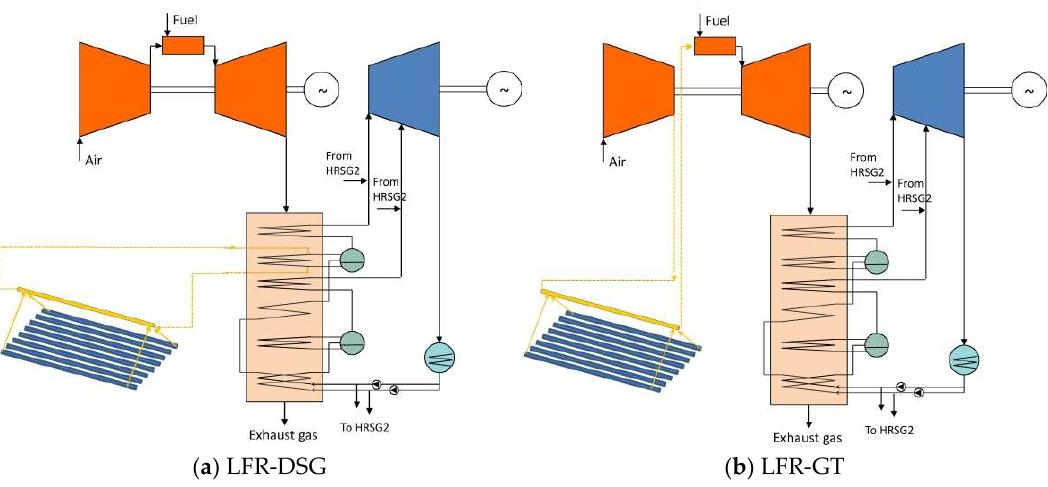
Figure 2. Layout of the configuration based on LFR.